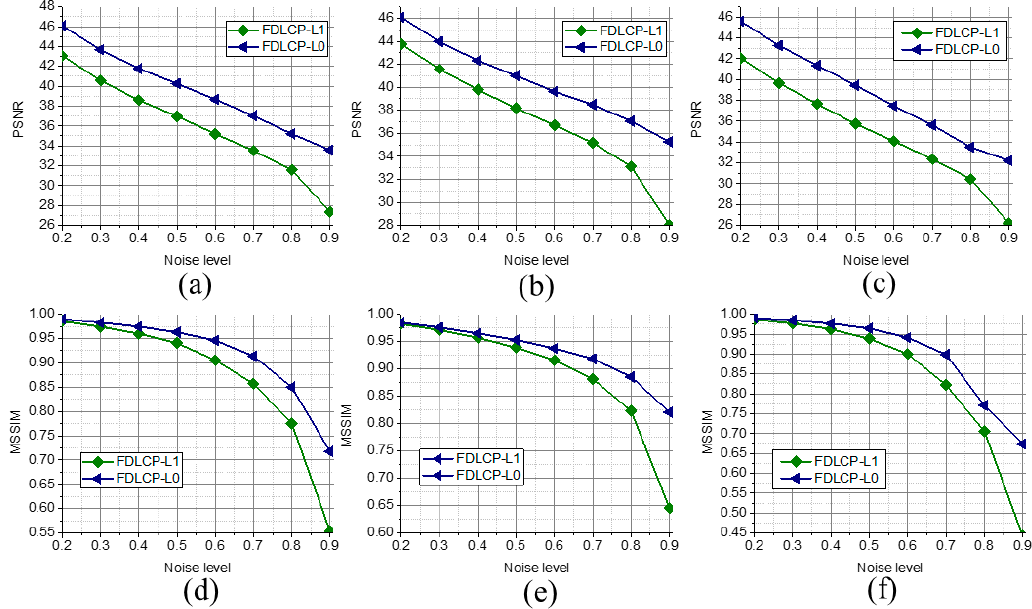
Figure 8. Comparisons on quantitative measure using FDLCP-L 1 and FDLCP-L 0 . ( a )–( c ) are PSNRs of Boat , Lena , and Barbara images, respectively; ( d )–( f ) are MSSIMs of Boat , Lena , and Barbara images, respectively. Table 2. PSNR performance under the salt and pepper noise using FDCLP with L 1 or L 0 norms.